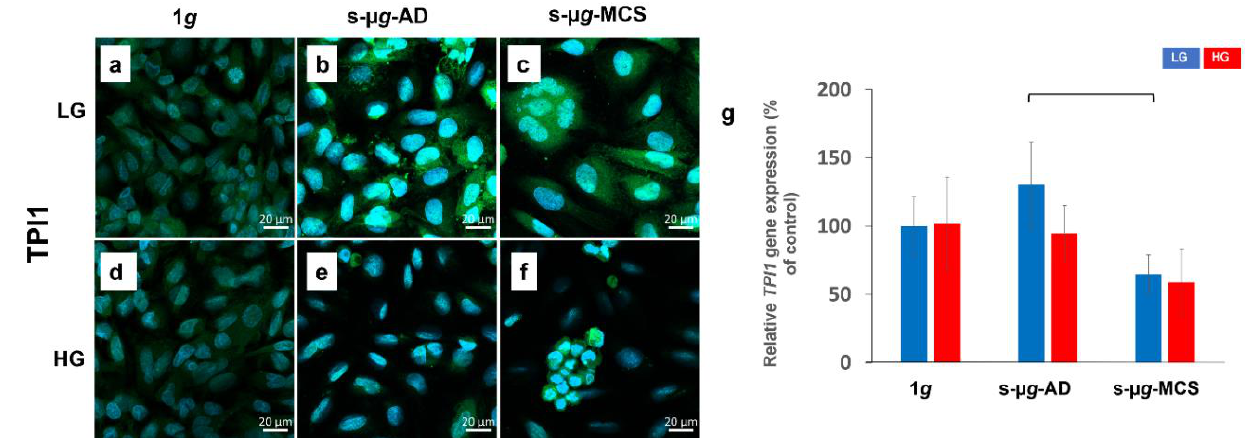
Figure 4. Analysis of TPI1 after 14 days of cultivation either at 1 g or s- µ g and either using low (LG) or high (HG) glucose medium. Data were obtained through immunostaining ( a – f ) and qPCR ( g ). The bracket stands for a significance level of p < 0.05.